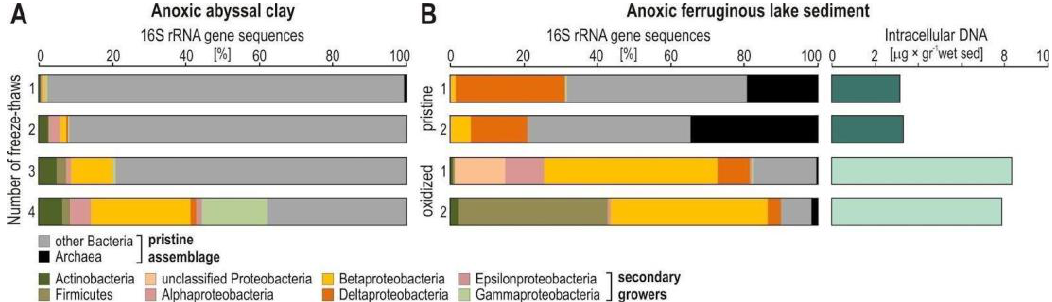
Figure 3. 16S rRNA gene taxonomic diversity in sediment samples showing secondary growth. ( A ) Relative abundances (%) of 16S rRNA genes in anoxic abyssal clay from the Northern Atlantic Ocean subjected to repeated freeze–thaws that led to oxidation of pore water ammonia with secondary growth during successive biological replicates (1 to 4). ( B ) Relative abundances (%) of 16S rRNA genes in ferruginous sediments from 0.5 cm (1) and 7.5 cm (2) depth, with sediments stored unfrozen under anoxia in hermetic bags ( top ) and those that experienced oxygen diffusion in Falcon tubes ( bottom ). Secondary growth occurred due to pore water oxidation during the 4 months of sample storage, which also resulted in higher intracellular DNA concentrations in the aforementioned oxidized (light green) than pristine (dark green) (light green) ferruginous sediment samples.